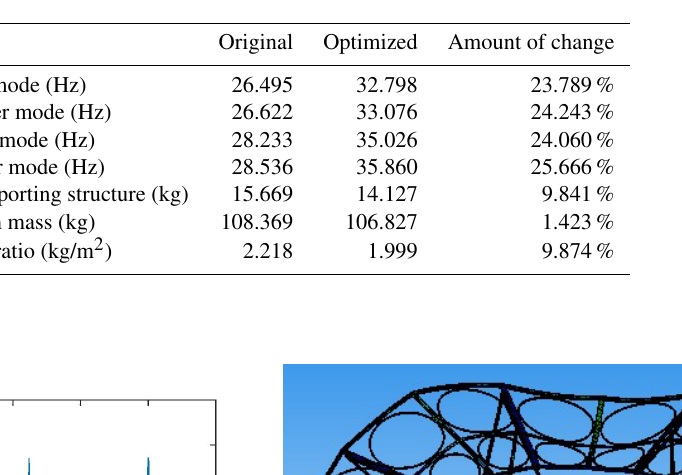
Table 9. Optimization results of the thin-film diffraction imaging system.